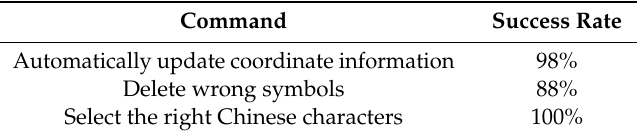
Table 5. The experimental results (testing times: